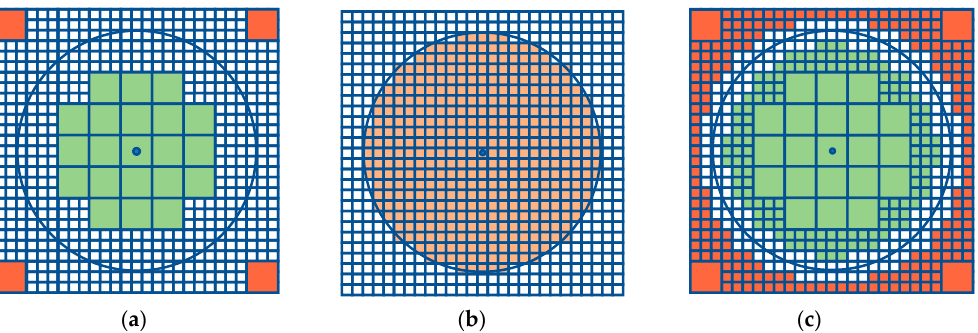
Figure 6. ( a ) White cells represent the search space at resolution 𝑖 + 1 . ( b ) Orange cells represent the offset region at resolution 𝑖 + 1 . ( c ) Red cells at resolution 𝑖 and 𝑖 + 1 are fully outside the offset region while green cells are fully inside (based on vertex neighbour check). White cells represent the fringe cells at resolution 𝑖 + 1 .